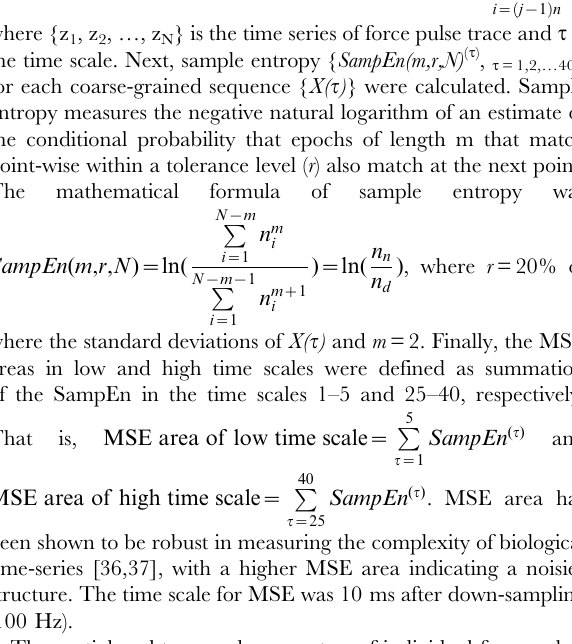
Figure 1(b) contrasts the force profile, ideal force trajectory,